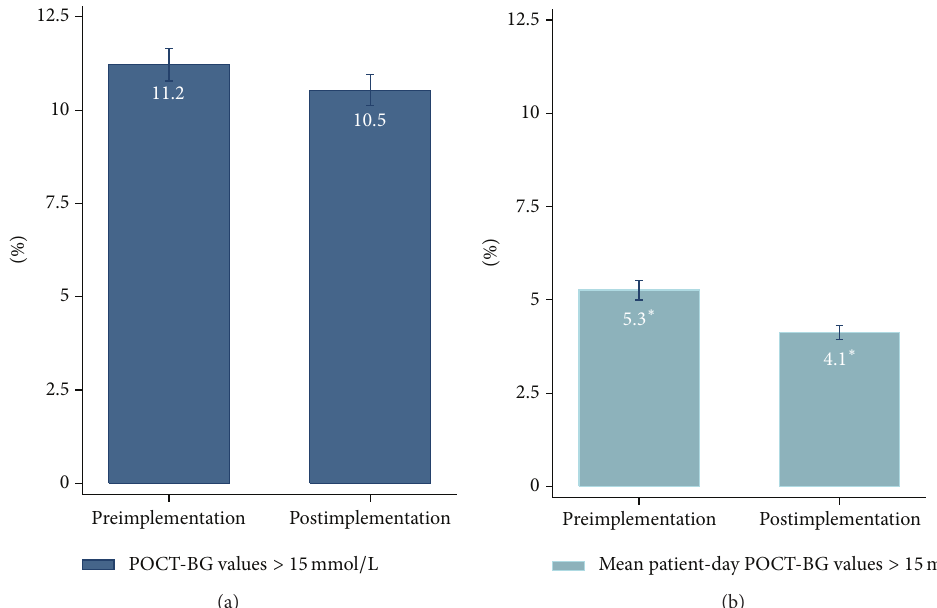
Figure2:Verticalbargraphsshowingthepercentageofhyperglycaemic( > 15 mmol/L)(a)POC-BGvaluesand(b)meanpatient-dayweighted POC-BG values. There was a significant reduction (greater than 20%) in mean patient-day weighted POC-BG values > 15 mmol/L after implementation of the alert system. ∗ 𝑝 < 0.05